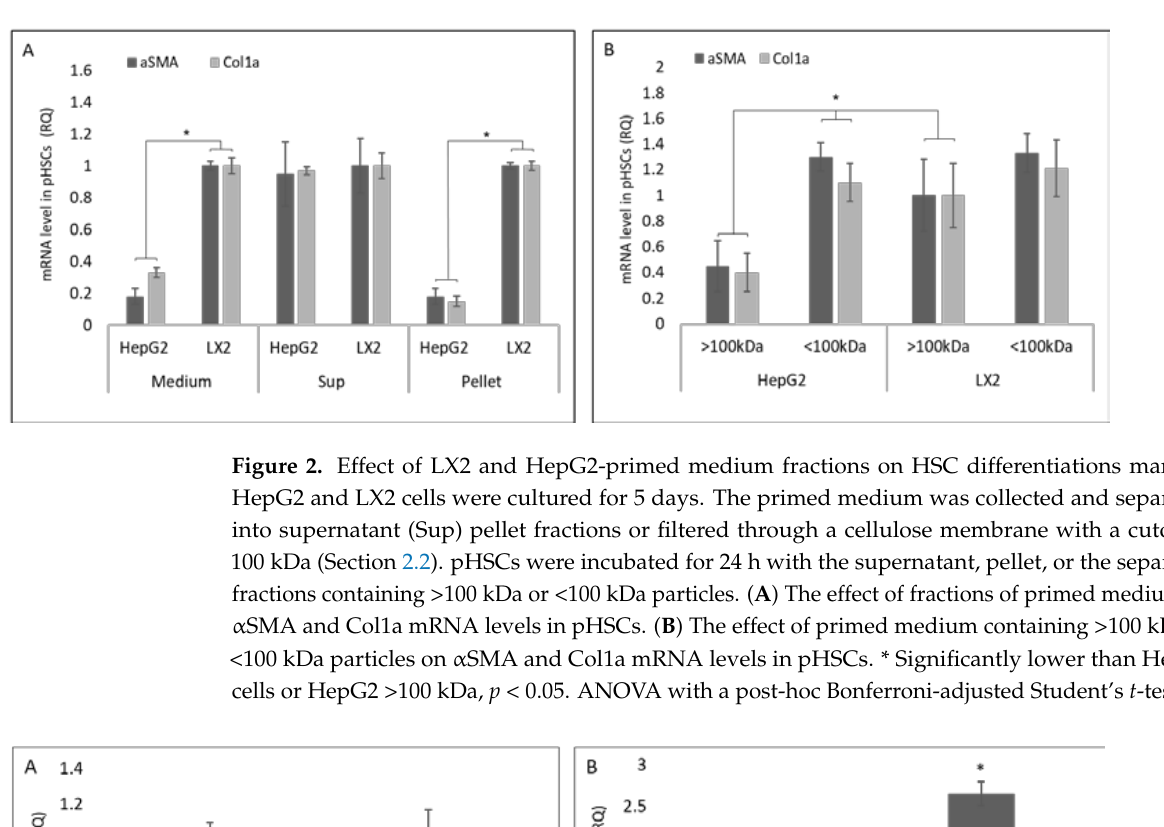
Figure 2. Effect of LX2 and HepG2-primed medium fractions on HSC differentiations markers. HepG2 and LX2 cells were cultured for 5 days. The primed medium was collected and separated into supernatant (Sup) pellet fractions or filtered through a cellulose membrane with a cutoff of 100 kDa (Section 2.2). pHSCs were incubated for 24 h with the supernatant, pellet, or the separated fractions containing >100 kDa or <100 kDa particles. ( A ) The effect of fractions of primed medium on αSMA and Col1a mRNA levels in pHSCs. ( B ) The effect of primed medium containing >100 kDa or <100 kDa particles on αSMA and Col1a mRNA levels in pHSCs. * Significantly lower than HepG2 cells or HepG2 >100 kDa, p < 0.05. ANOVA with a post-hoc Bonferroni-adjusted Student’s t -test.